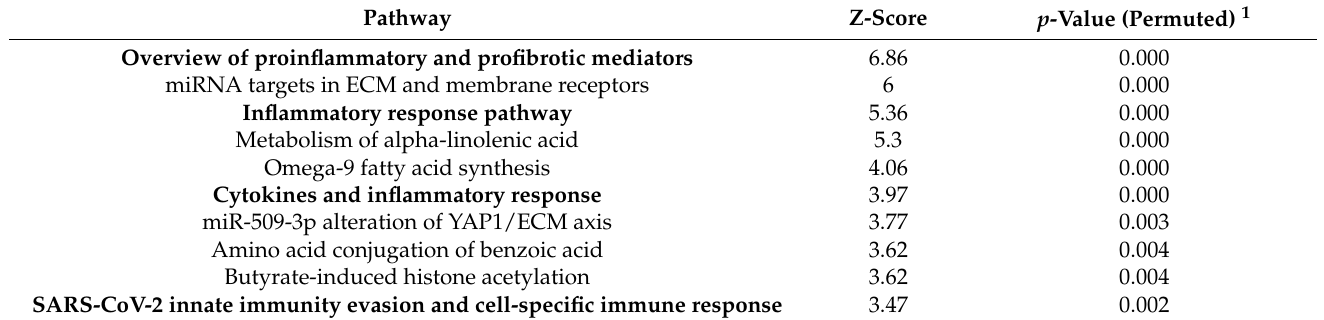
Table 6. Top 10 significant pathways for the Phenion ® Full-Thickness Skin model exposed to Perfectha ® SubSkin filler. DEGs selected by moderated t -test with adjusted p -value < 0.2 were used for ORA in PathVisio. Pathways related to immune and inflammatory response are shown in bold.